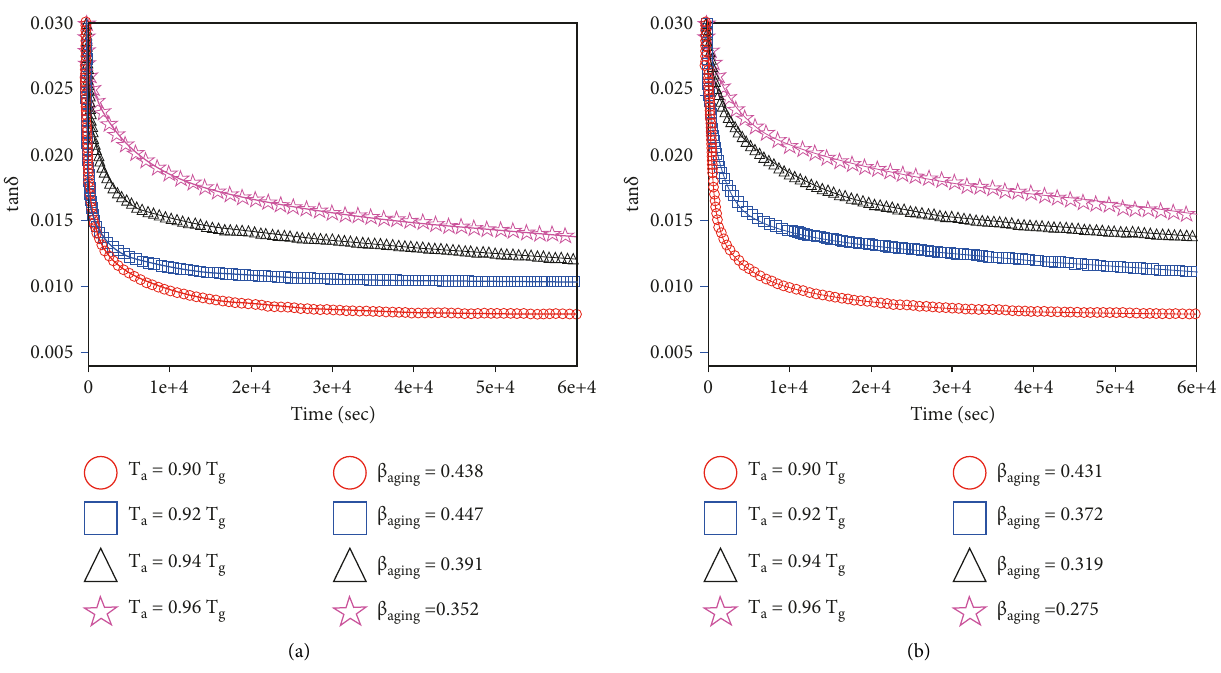
Figure 5: Loss factor as a function of aging time for (a) ZrCoAl and (b)